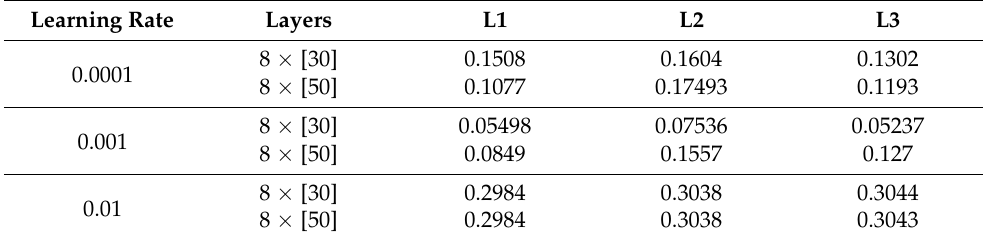
Table 3. Relative error of links for the fixed tanh activation function.